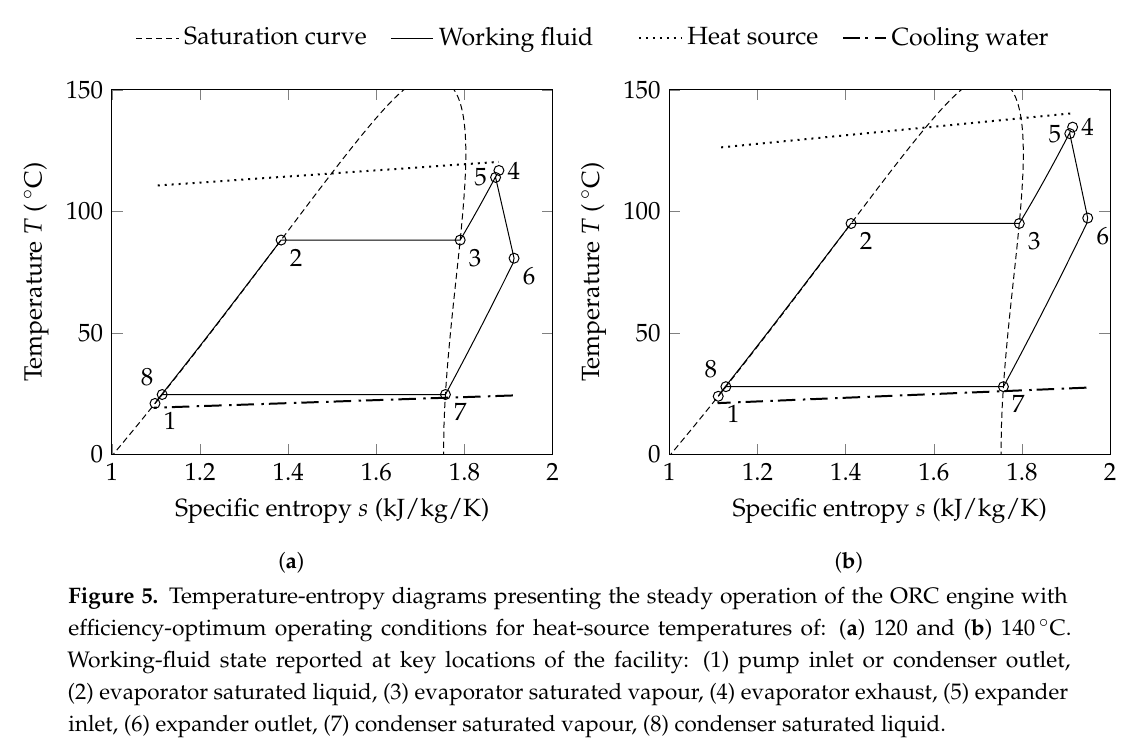
Figure 5. Temperature-entropy diagrams presenting the steady operation of the ORC engine with efficiency-optimum operating conditions for heat-source temperatures of: ( a ) 120 and ( b ) 140 ◦ C. Working-fluid state reported at key locations of the facility: (1) pump inlet or condenser outlet, (2) evaporator saturated liquid, (3) evaporator saturated vapour, (4) evaporator exhaust, (5) expander inlet, (6) expander outlet, (7) condenser saturated vapour, (8) condenser saturated